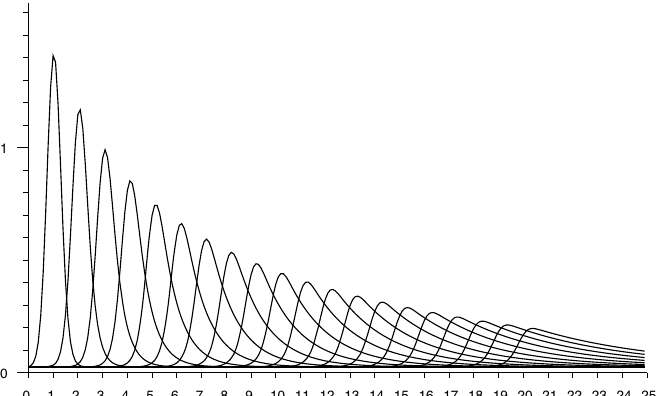
Figure 8. Conditional probability of observing a distance measurement (horizontal axis—meters) taking into account random measurement error with st. dev. of 0.25 m. Each curve corresponds to a different value for the actual distance. Curves shown for actual distance of 1 m, 2 m, . . ., 20